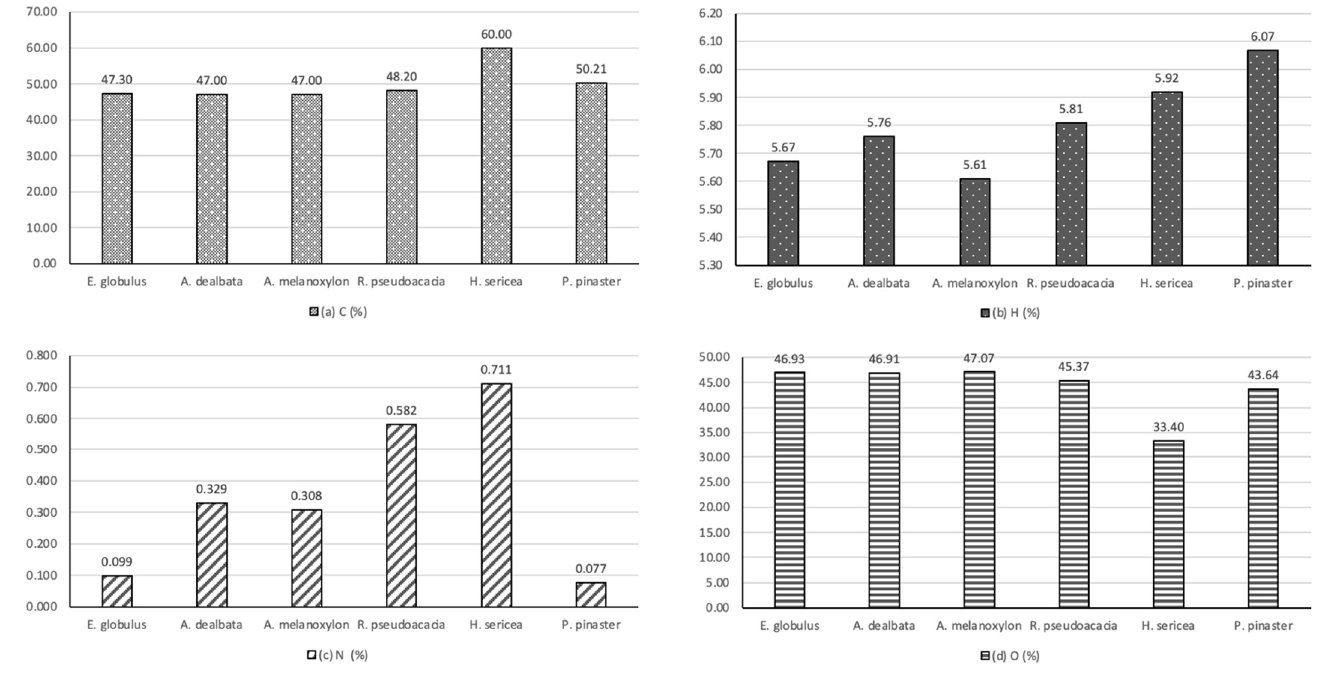
Figure 3. Results of the elemental analysis CHNO.